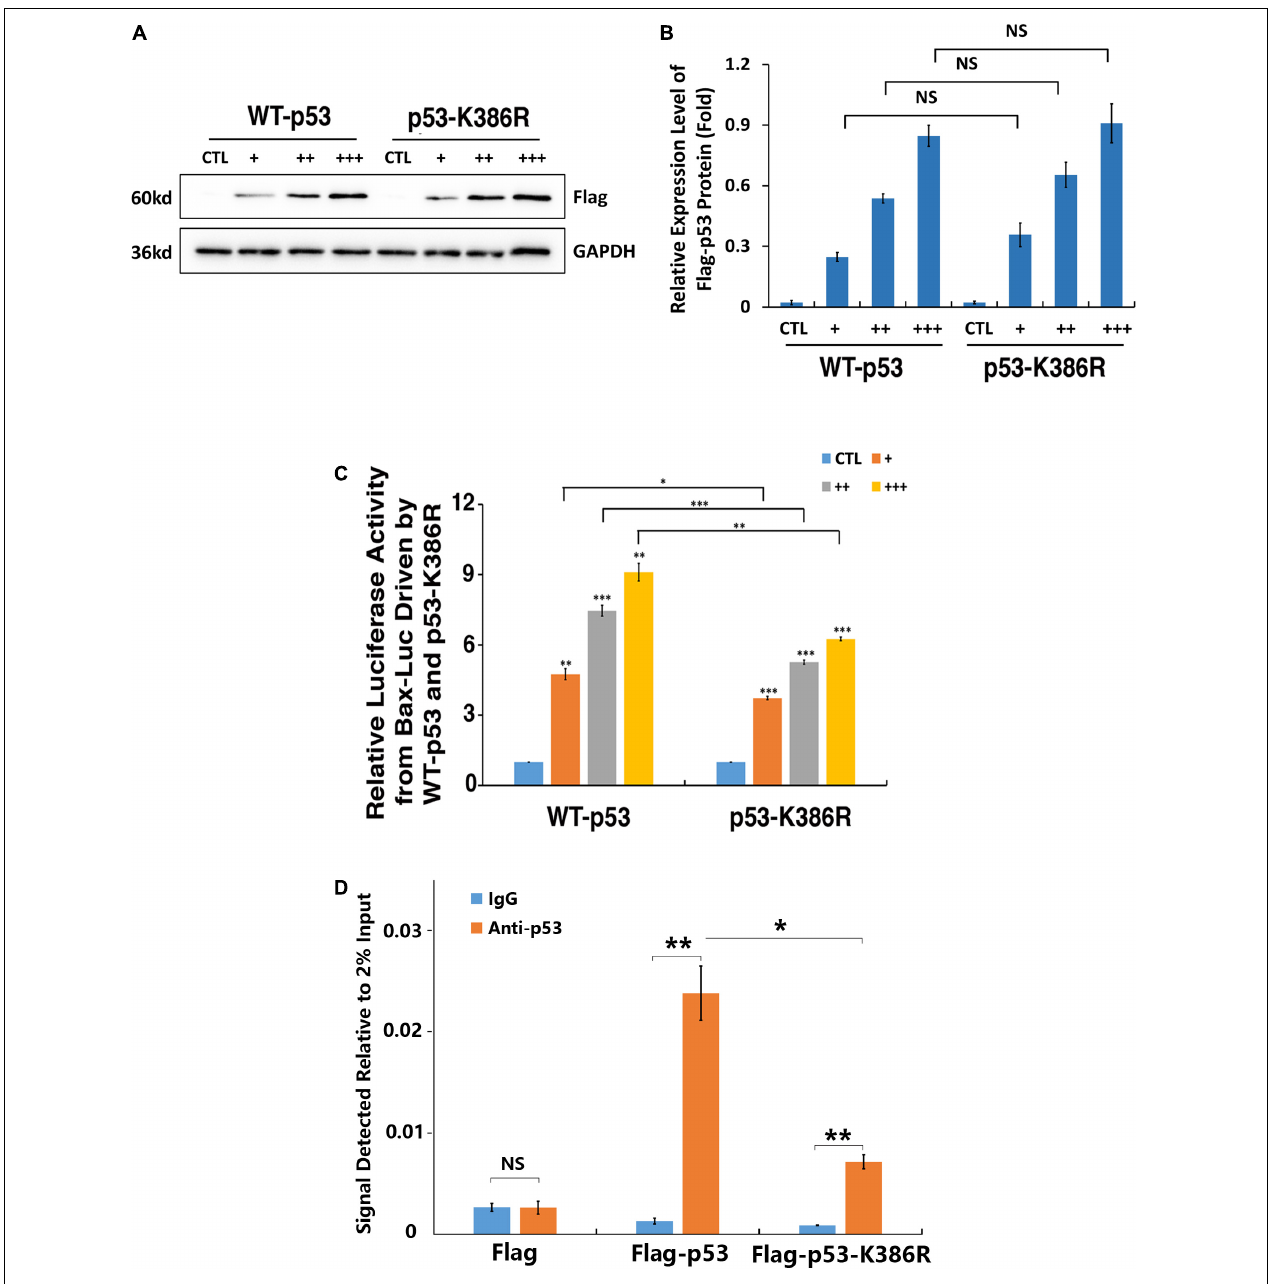
FIGURE 7 | p53 sumoylation at K386 enhances the binding with Bax promoter. (A–C) p53-KO α TN4-1 cells were co-transfected with 1 µ g of pGL3-Bax, 50 ng of pRL-TK, and empty vector (CTL), Flag-p53-WT, or Flag-p53-K386R at three different doses, 50 ng/well (+), 100 ng/well (++), and 200 ng/well (+++). (A) The Western blot analysis was conducted to detect exogenous p53 expression levels. The GAPDH was used as a loading control. (B) Quantification of the Western blot results in panel (A) . (C) Dual-luciferase activity was measured 36 h after transfection. (D) p53 sumoylation deficiency decreased the occupancy of p53 on the Bax promoter as measured by ChIP assay. ChIP was performed using an anti-p53 antibody and IgG as a negative control in p53-KO cells transfected with Flag, Flag-p53-WT, or Flag-p53-K386R. The occupancy was normalized to 2% DNA input and calculated in comparison with IgG control. All experiments were repeated three times. Error bar represents standard deviation, N = 3. NS, not significant, * p < 0.05, ** p < 0.01, *** p <